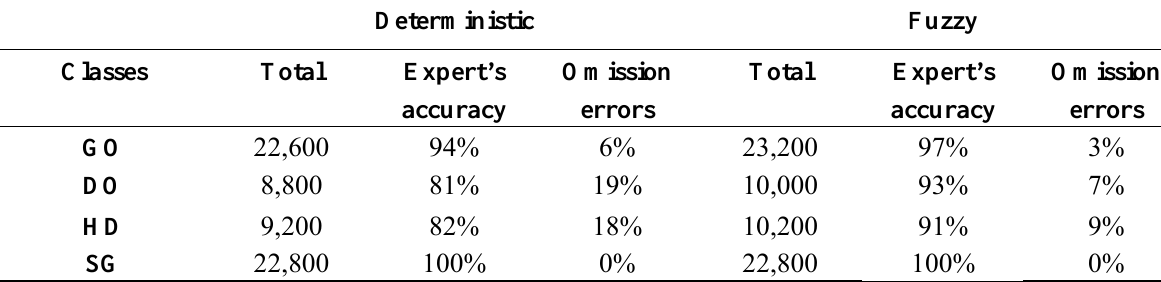
Table 4. Expert’s accuracy and omission errors.